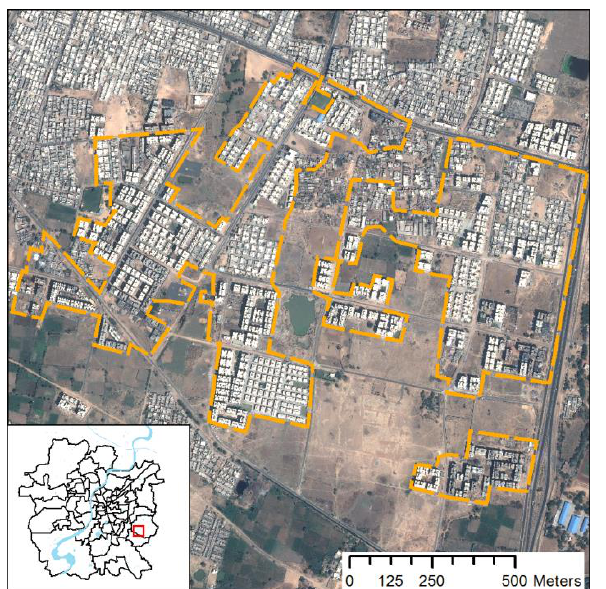
Figure 5: Investigated area of Ward 47 “Vastral”